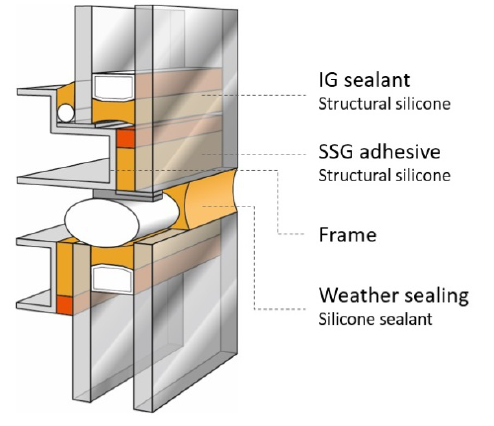
Fig. 3 Typical Structural Sealant Glazing (SSG) System